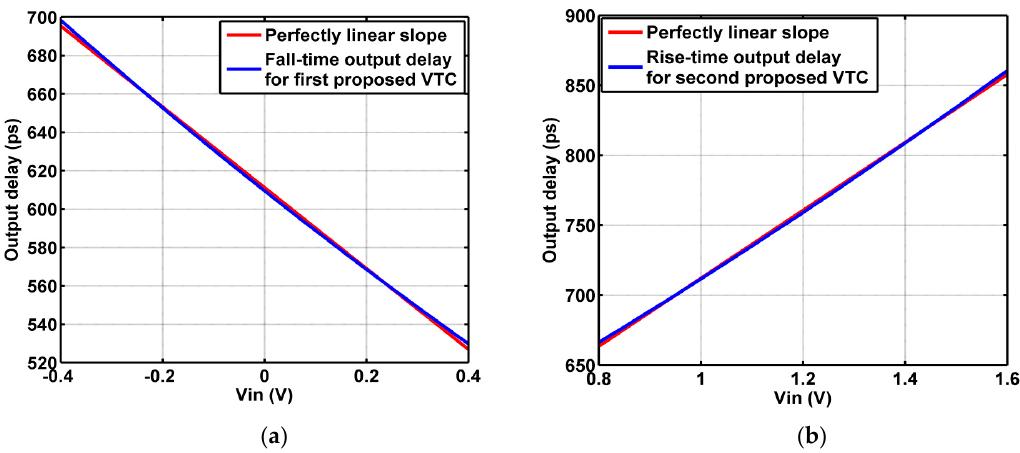
Figure 9. ( a ) Output delay versus a perfect linear slope for the first proposed VTC. ( b ) Output delay versus a perfect linear slope for the second proposed VTC.